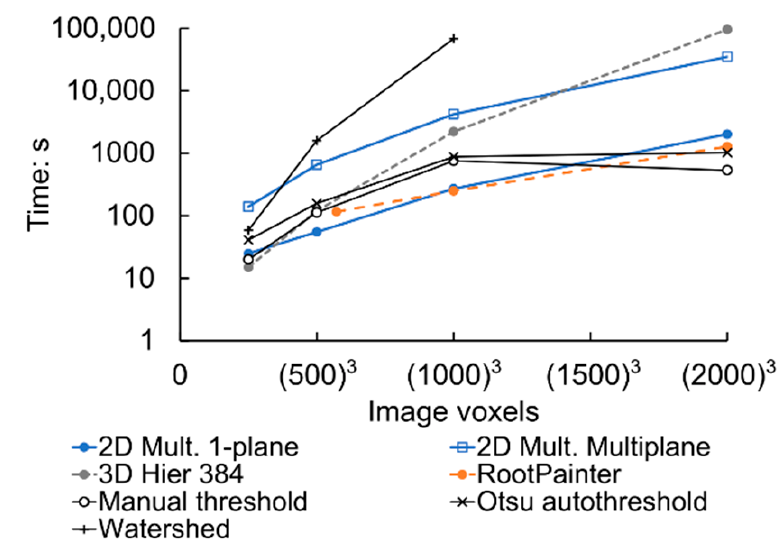
Figure 8. Segmentation time required using an Nvidia Tesla V100 ® GPU for the U-Net methods and HPCC of 40 × Intel Gold 6242R ® CPU @ 3.10 GHz for the standard methods. Benchmarking data were extracted from the reconstructed and post-processed scan IC01 and are available from Alvarez-Borges et al. [49]. Excludes time spent on the preparation of training